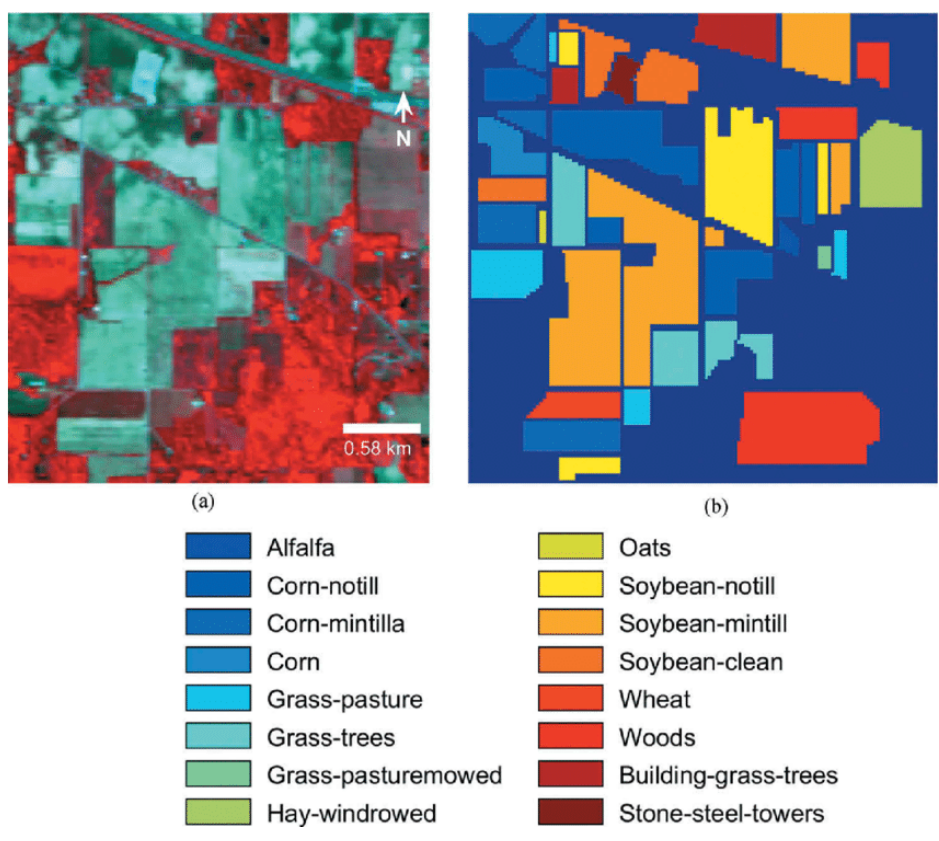
Figure 2. Classified Contrast of Indian Pines